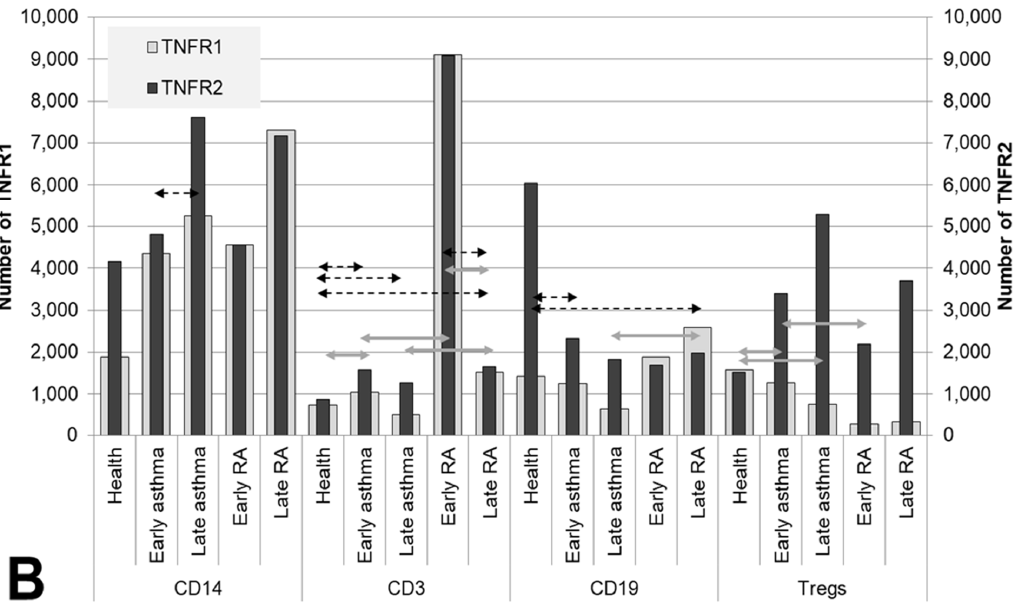
Figure 1. Co-expression ( A ) and density ( B ) of TNF receptors of types 1 and 2 in major subsets of immunocompetent cells. Arrows indicate significant ( p < 0.05, Kruskal–Wallis test for multiple comparisons) differences in the expression level of TNFR1 between healthy individuals and RA patients or asthma and between patients at the same stage of the disease (between early RA and early asthma and between late RA and late asthma). Light grey arrows indicate differences for TNFR1, dark grey arrows indicate differences for